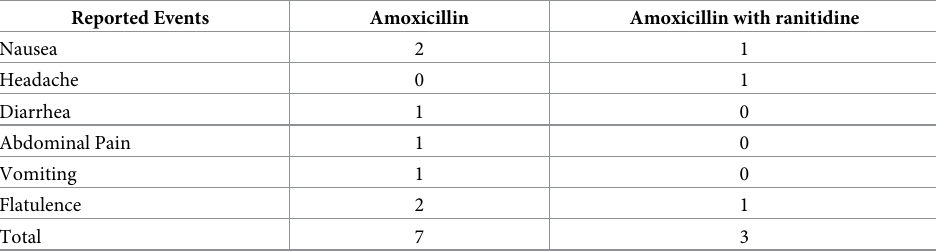
Table 6. Adverse events reported by subjects.